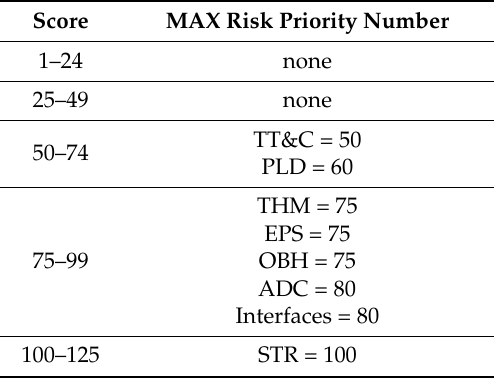
Table 17. Maximum RPN of each